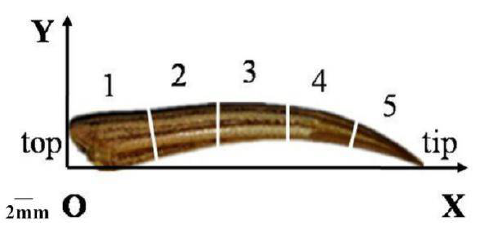
Figure 2. Coordinate grid with Chinese mitten crab dactylopodites.